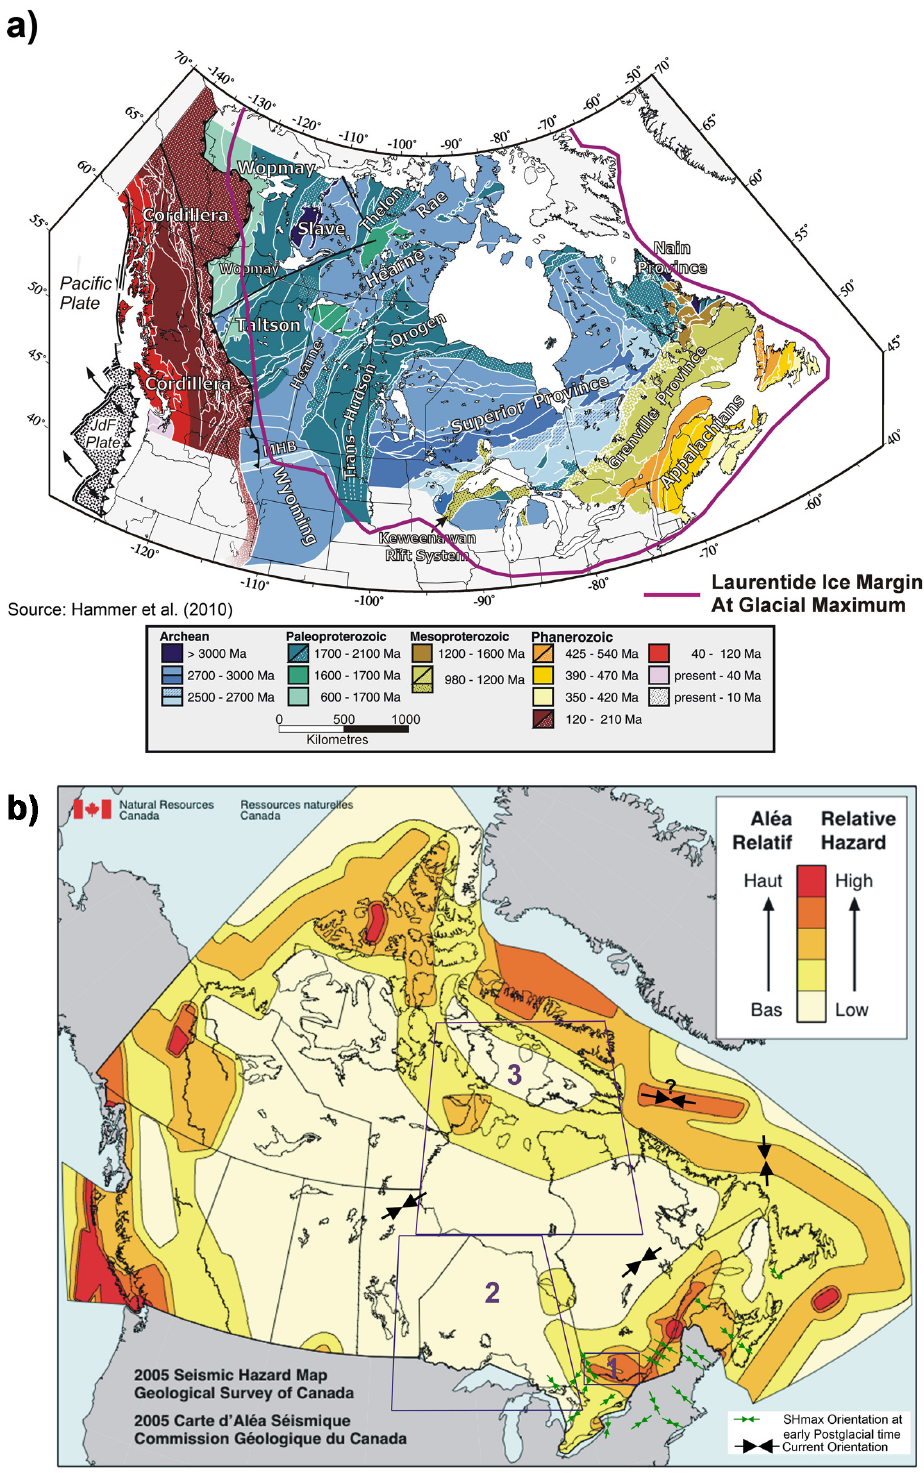
Fig. 1. (a) A simplified tectonic map of Canada. Tectonic age is defined as the time since the most recent episode of tectonic deformation. Tectonic ages in Baffin Island, not shown in the figure, are comprised of both Archean and Paleoproterozoic ages. The dark purple line marks roughly the Laurentide ice margin at glacial maximum. (b) 2005 seismic hazard map of Canada (http://earthquakescanada.nrcan.gc. ca/hazard-alea/) showing the three regions considered for study. SHmax (maximum horizontal stress) orientations for early postglacial times and the current orientations are also